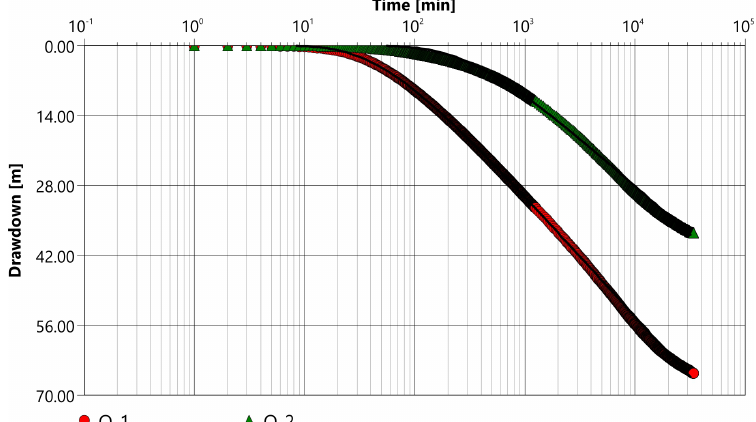
Figure 12. Analytical diagram for measurements during recovery in observation wells O-1 and O-2 (Theis method + Agarwal’s solution).